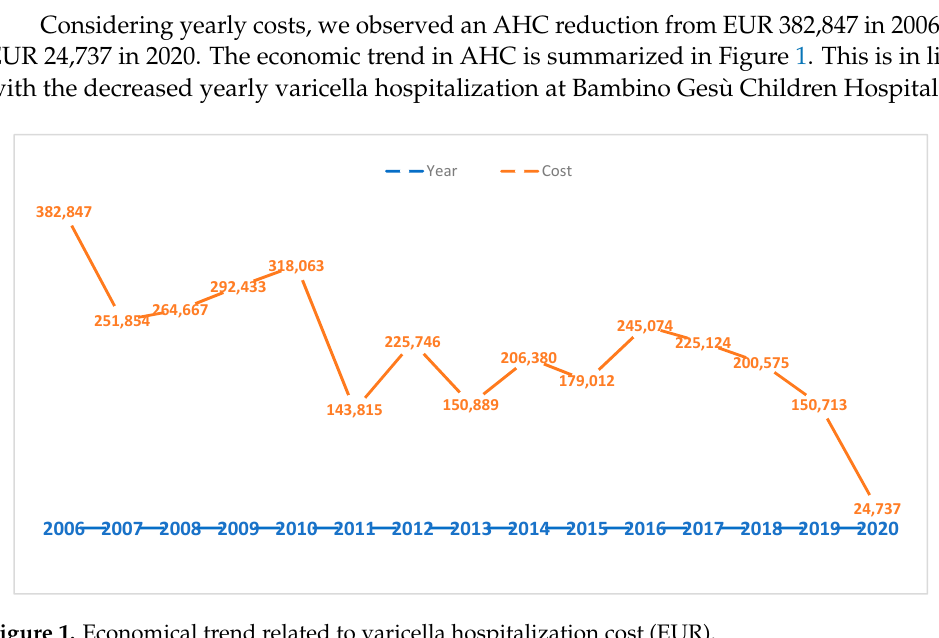
Table 1. Varicella hospitalization acute cost.